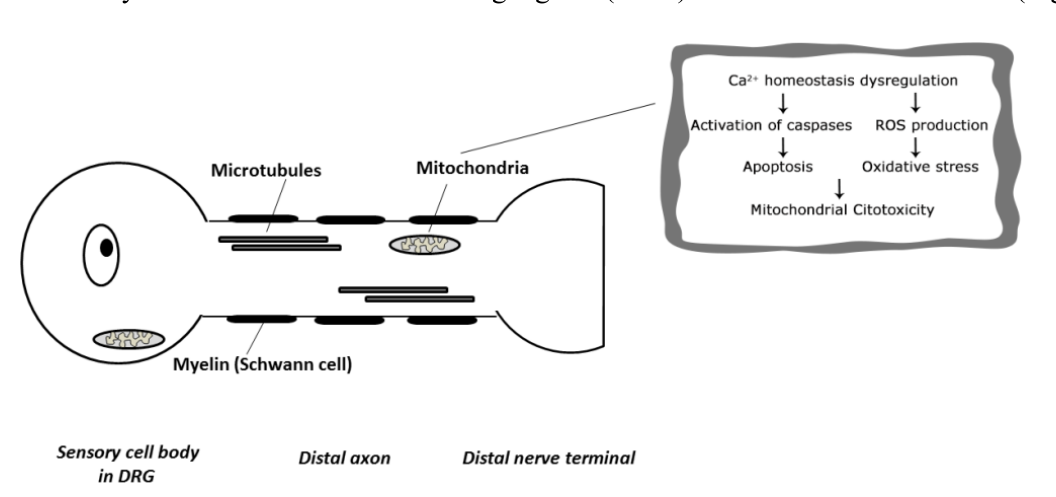
Figure 1. Target of Bortezomib-induced Neuropathy in the Peripheral Nervous System (ROS: reactive oxygen